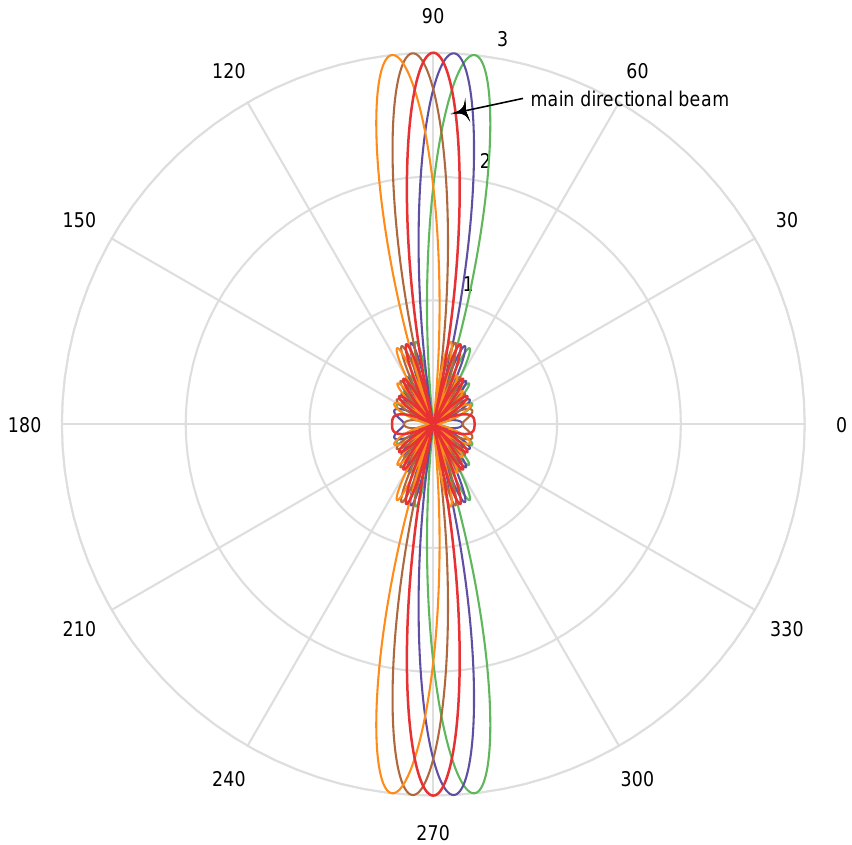
Figure 4. Last layer of beam pattern in primary codebook and auxiliary codebook when N = 9, α =